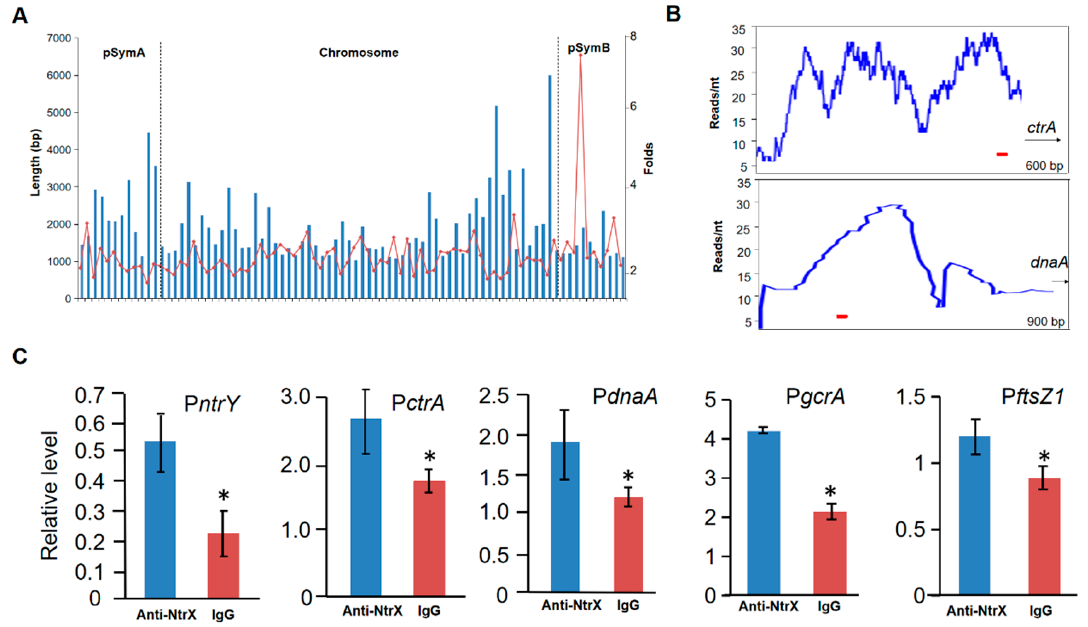
Figure 5. NtrX binding to the promoter DNA of key cell cycle regulatory genes in vivo. ( A ) Genome- wide distribution of DNA fragments precipitated by anti-NtrX antibodies through a ChIP-Seq assay. ( B ) Peak maps showing the promoter fragments of ctrA and dnaA in the ChIP-Seq assay. Red bars, the putative NtrX recognition site, CAAN 2-5 TTG. ( C ) Enrichment of DNA fragments containing ctrA , gcrA and dnaA promoters determined by ChIP-qPCR. IgG, S. meliloti lysate treated by IgG as a neg- ative control. Error bars, ±SD. The Student’s t -test was used for significance analysis. *, p < 0.05.